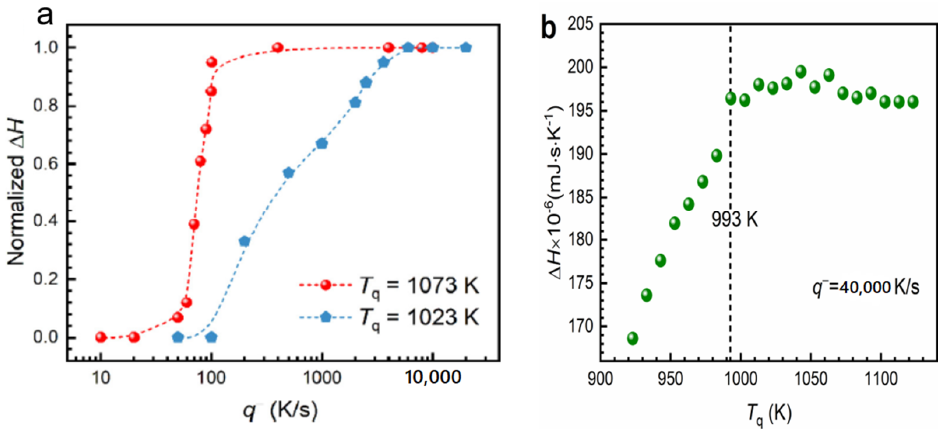
Figure 11. The content of amorphous phase as a function of cooling rate q− of the samples ob- tained from T q = 1073 and 1023 K, respectively ( a ). The crystallized fraction characterized by ΔH is evaluated by FDSC as shown in Figure 10b. Area of the second exothermic peak ΔH as a function of T q as shown in Figure 10. ( b ) Area of the exothermic peak  H as a function of T q with a cooling rate of 40,000 K/s. Reprinted with permission from ref. [21], Figure 3b and Figure S1, Copyright Reprinted with permission from ref. [21], Figure 3b and Figure S1, Copyright 2021 2021 Elsevier.